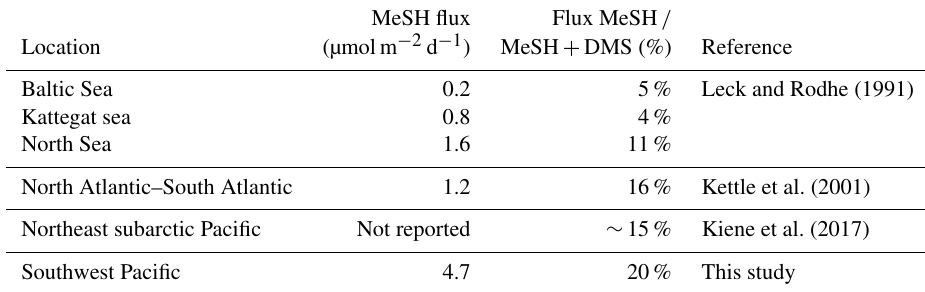
Table 5. MeSH flux from this and previous studies (voyage